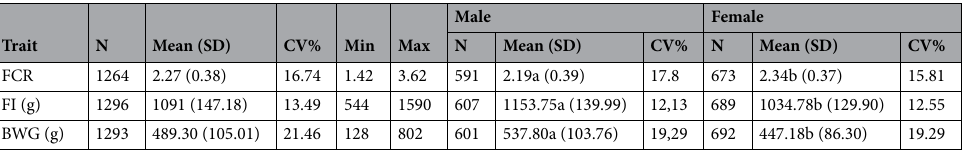
Table 1. Descriptive statistics of feed conversion ratio (FCR), feed intake (FI) and body weight gain (BWG) from 35 to 41 days of age for the broiler population used in this study. N number of records. CV coefficient of variation. a–b Means in same row with different letters are significantly different (p < 0.001).